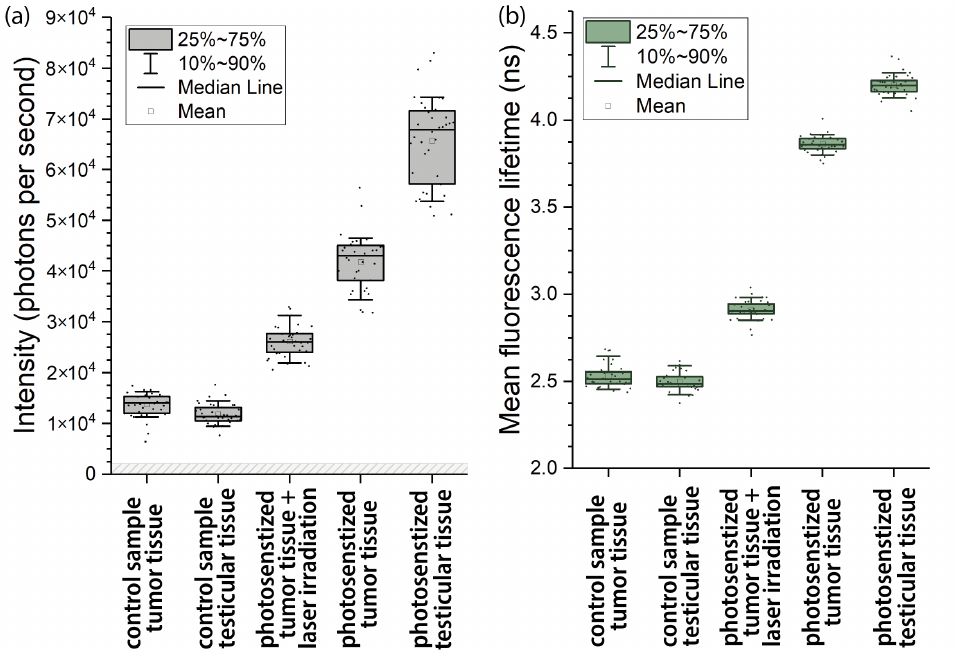
Figure 2. Statistical results for the mean intensity ( a ) and mean lifetimes ( b ) of the fluorescence signals in tissue samples within the spectral range of 608–683 nm.